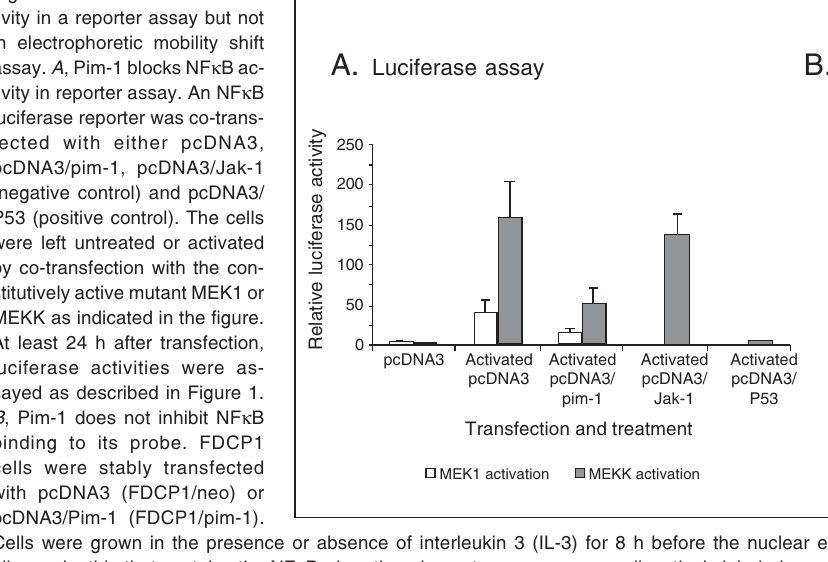
Figure 5. Pim-1 inhibits NF κ B ac- tivity in a reporter assay but